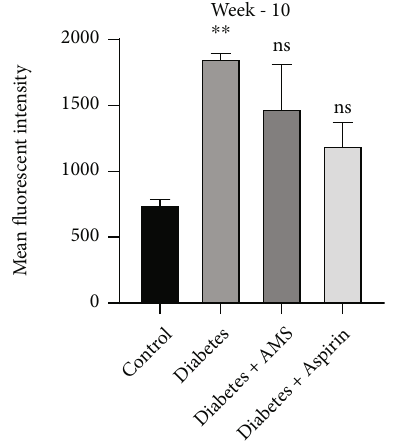
Figure 6: Macrophage platelet interaction in the control, diabetes, and treatment groups. All values are represented as mean ± SEM ( N = 3 -5). ∗∗ p < 0 : 01 vs. the control; ns: nonsigni fi